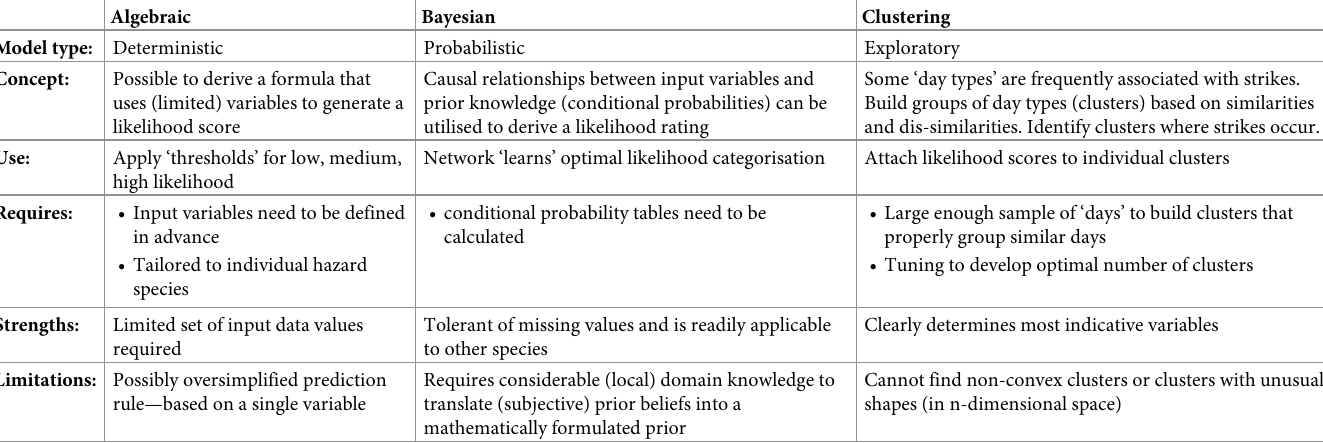
Table 1. Summary of modelling